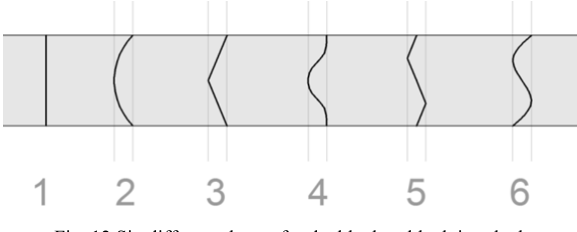
Fig. 12 Six different shapes for the block to block